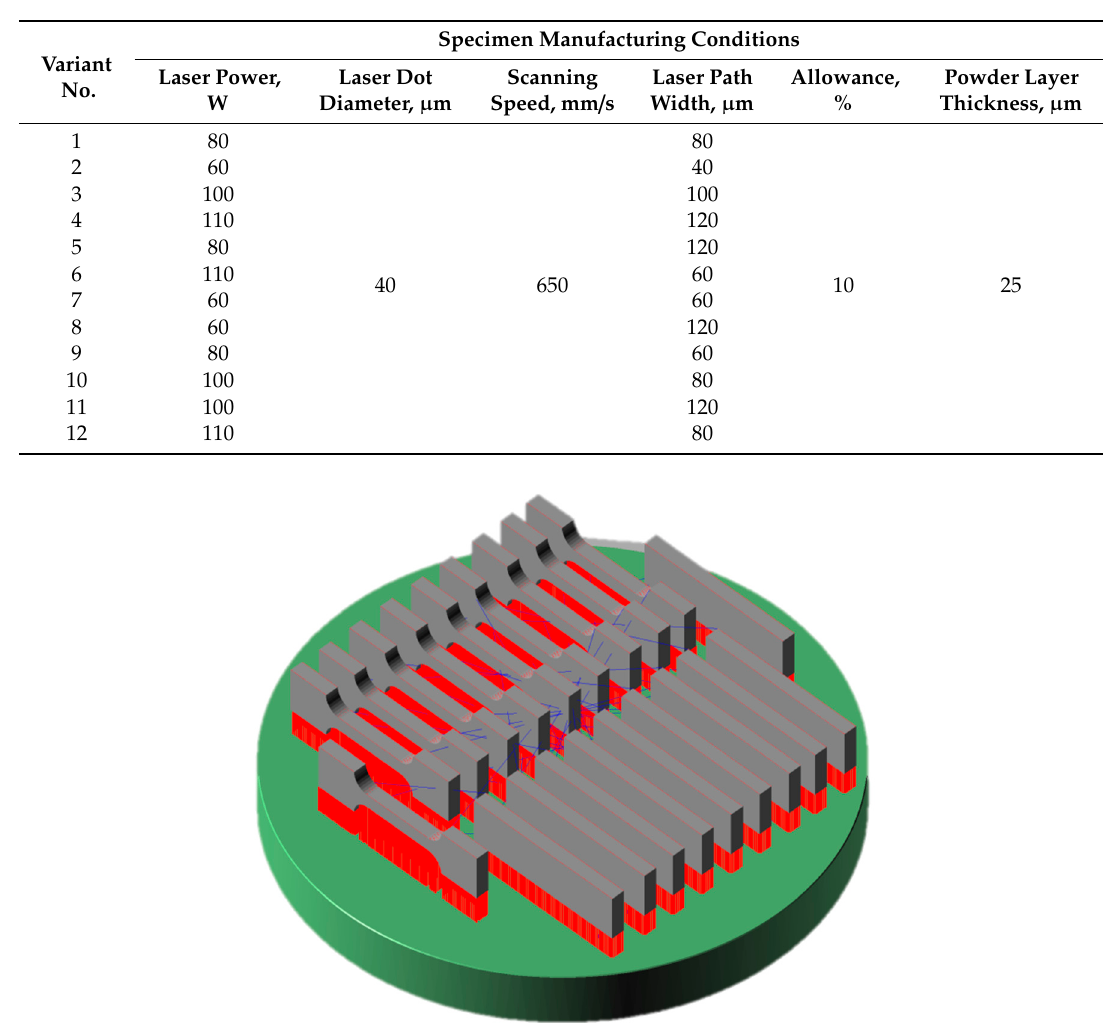
Table 3. Variants of conditions for preparing specimens from Ti6Al4V alloy by selective laser sintering (SLS) method.